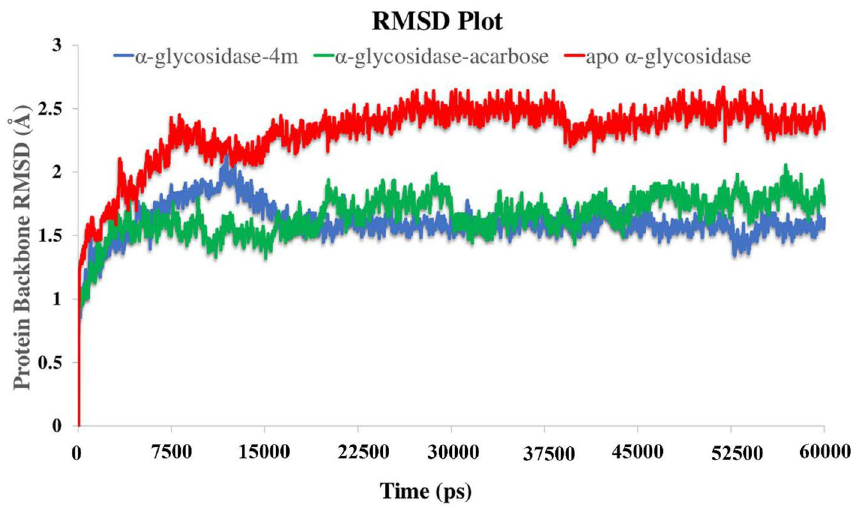
Figure 8. RMSD of the α-glucosidase backbone in complexed with acarbose (in green), compound 4m (in blue) and the unbound enzyme (in red) for over 60 ns MD simulation time (Desmond